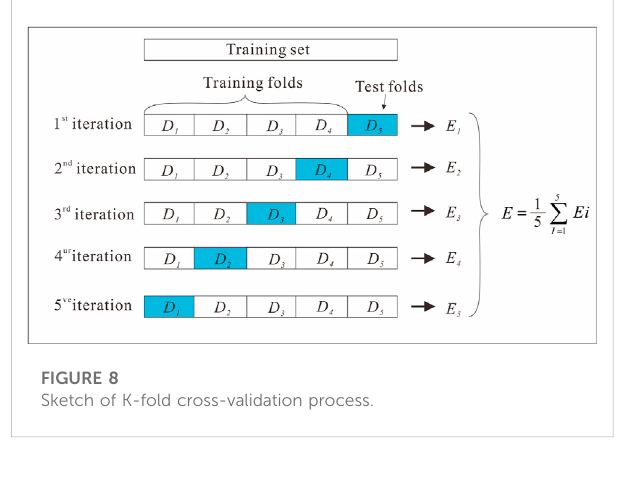
FIGURE 8 Sketch of K-fold cross-validation process.